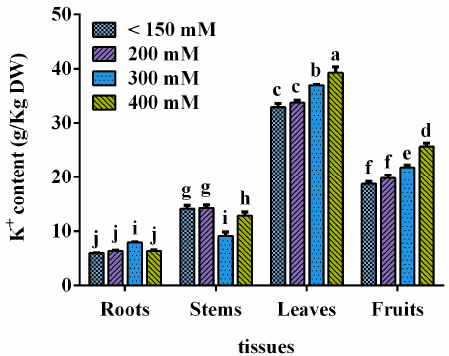
Figure 1. Ion contents of different tissues for L . ruthenicumin in different saline soils. DW means dry weight. The mean ± standard error (SE) of five replicates is presented. The lowercase letters on the histogram indicate p < 0.05.